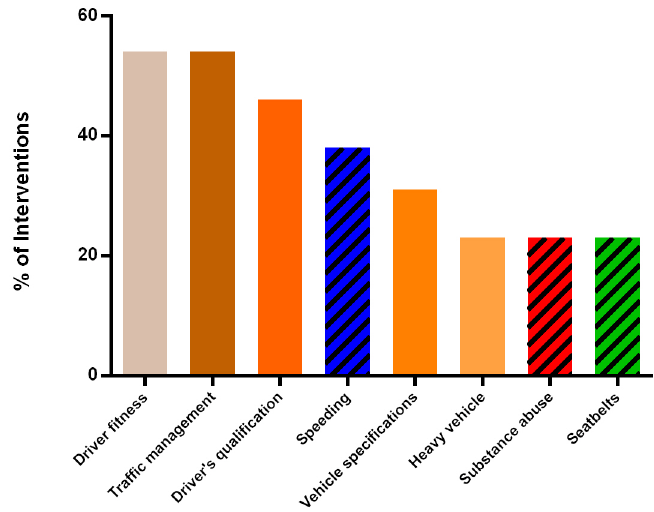
Figure 3. Key issues of “inside” interventions ( n =